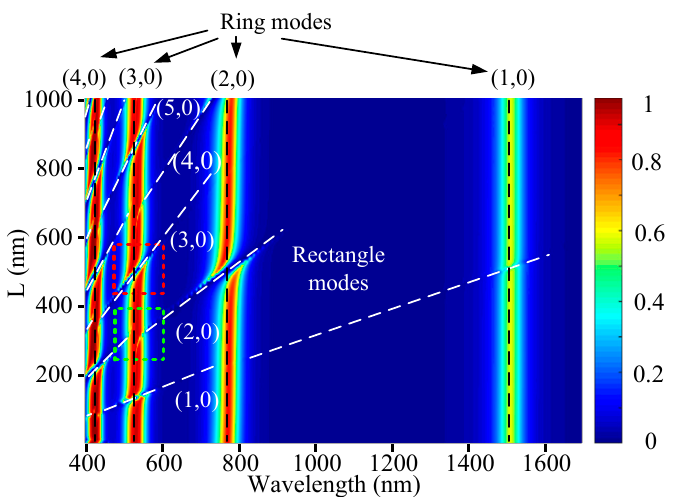
Figure 3. Nephogram of Fano resonance transmission spectrums coupled by metal-insulator-metal (MIM) ring resonator and rectangle resonator with the rectangle resonator L varying from 0 to 1000 nm. In the nephogram, the black dashed lines represent a series of transmission resonance peaks of different resonance modes in a single ring MIM waveguide. The corresponding resonance modes are ring modes (1,0), (2, 0), (3, 0), (4, 0) from right to left, respectively. The white dashed lines represent a series of transmission resonance peaks of resonance modes in the rectangle MIM waveguide. The corresponding resonance modes are rectan- gle modes (0,1), (0, 2), ..., and (0, 5), ..., respectively. The red-yellow parts are the transmis- sion spectrums of the interaction between ring modes and ring modes. The split parts of the red-yellow parts (e.g., the parts in dotted red and dotted green boxes) are the results of Fano resonances between the modes in the ring resonator and the rectangle resonator. Through the analysis, very evident laws are found. When orders m of rectangle modes in the rectangle resonator and n of the ring modes in ring resonator are both odd or both even, the two modes in the ring and rectangle resonators strongly couple with each other, and the corresponding transmission spectrum bands of the Fano resonances are completely split (e.g., the parts of the dotted red box). While, when the orders, m , n , respectively are odd and even (even and odd), the two modes in the ring and rectangle resonators weekly couple with each other and the corresponding transmission spectrum bands of the Fano resonances are incomplete splits (e.g., the part of the dotted green box). Even the Fano resonance coupled by the ring mode (2, 0) and rectangle mode (1, 0) is extremely weak; the corresponding incomplete transmission spectrum band does not get demonstrated. For further analysis of the ‘direction’ line shapes of the Fano resonances for the com- plete and incomplete split transmission spectrum bands, the transmission spectrums in the dotted red and green boxes with different rectangle length L are shown in Figure 4a,b, respectively.